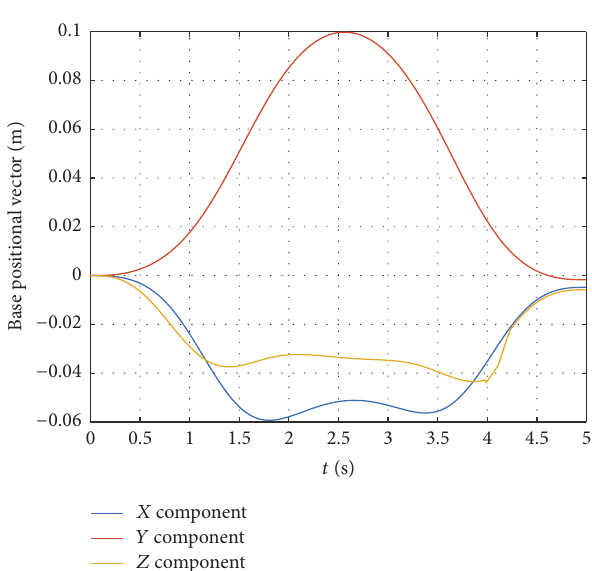
Figure 8: Pose error curves of the floating base. We also obtained joint trajectories based on the optimized parameters and drew pose curves of the base and the position curve of the end-effector. The results indicated that the proposed method can arrive at the desired state.